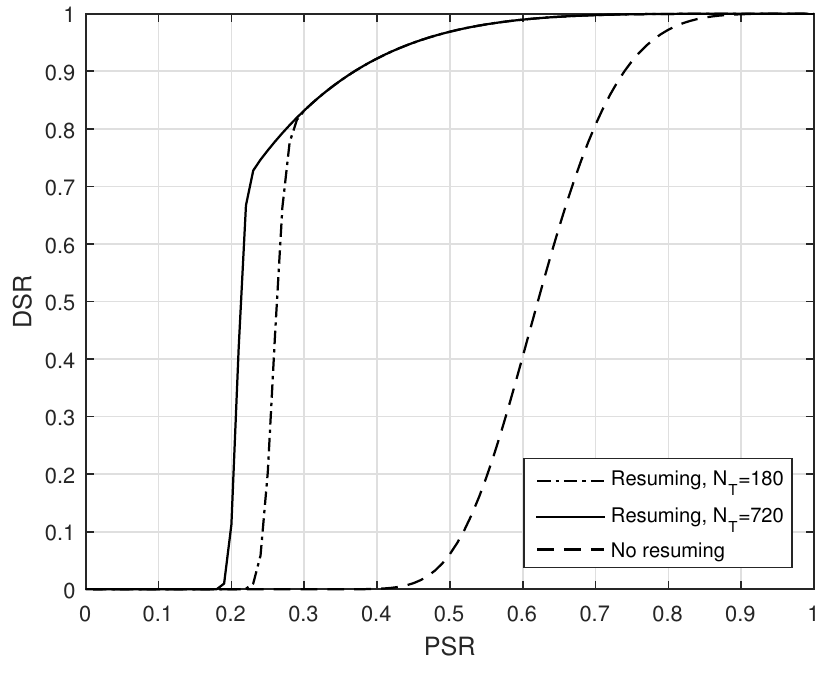
Figure 17. Download success